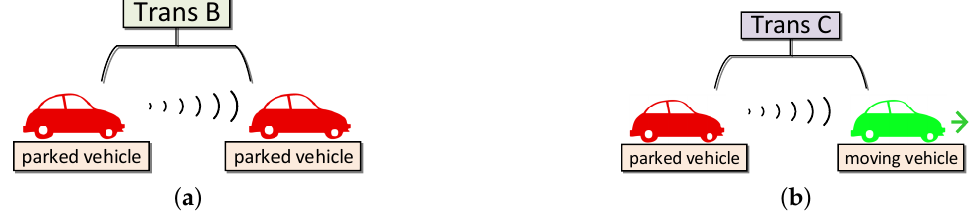
Figure 3. Transport protocol switch according to environment changes. ( a ) Relatively static peers. ( b ) Relatively moving